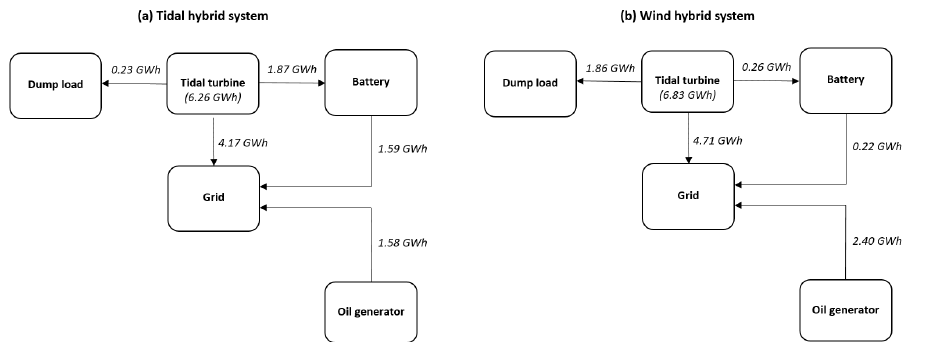
Figure 10. Annual energy flows in the ( a ) tidal and ( b ) wind energy